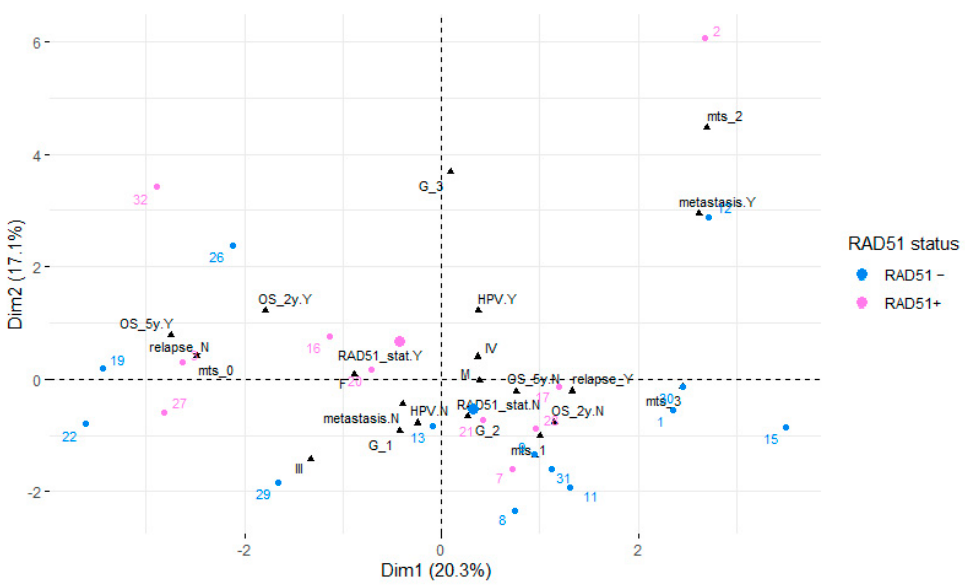
Figure 7. Factor analysis for mixed data showing the first factor plane. Individuals are colored depending on their RAD51 expression status.